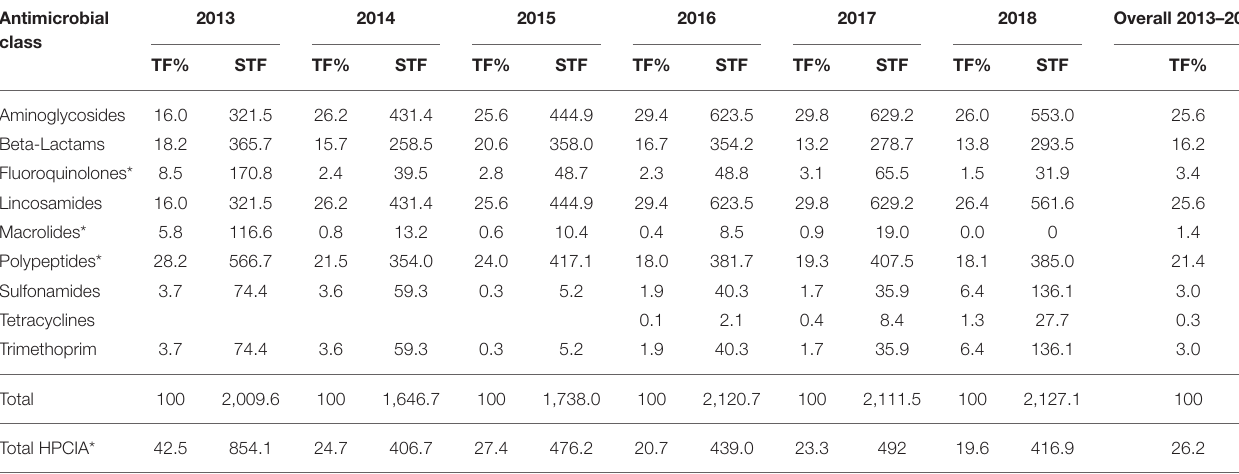
TABLE 3 | Relative (TF%) and absolute (total in all flocks) treatment frequency (STF) per antimicrobial class and year. Antimicrobial class